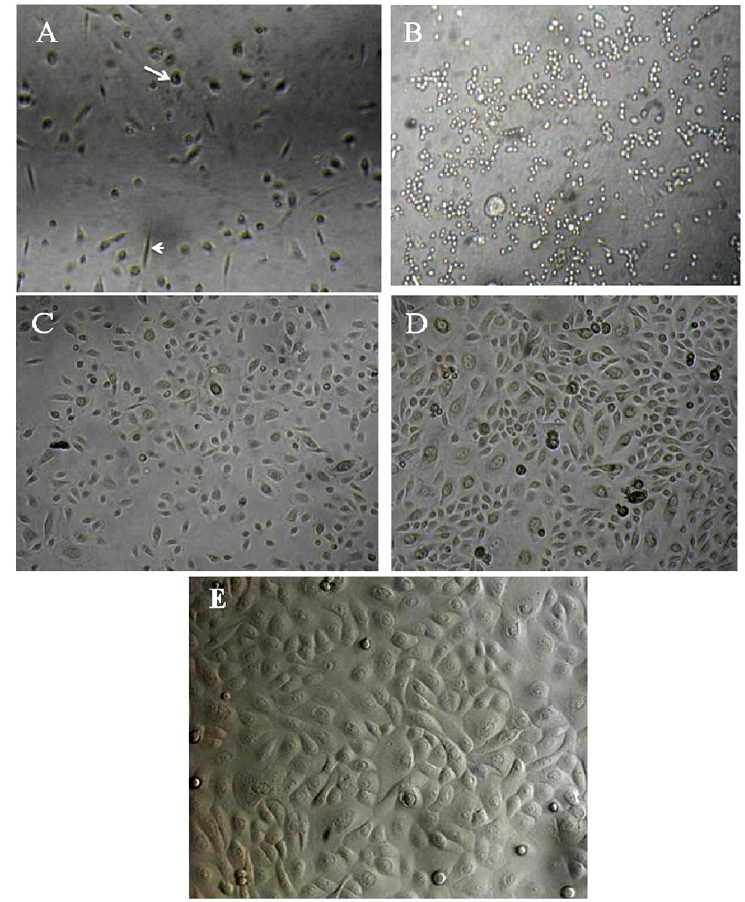
Figure 1. Primary culture (P0): heterogeneous cells, rounded cells (arrow), and fibroblast-like cells (arrowheads) ( A ); Attached epithelial-like cells after the selective digestion method ( B ); One day after the selective digestion ( C ); Colony formation began at day 7 ( D ); and the cells became confluent by day 10 ( E ). Magnification is